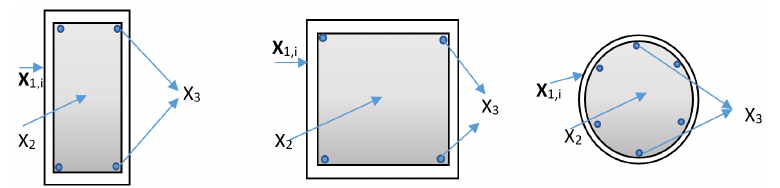
Figure 1. Groups of parameters that define the design